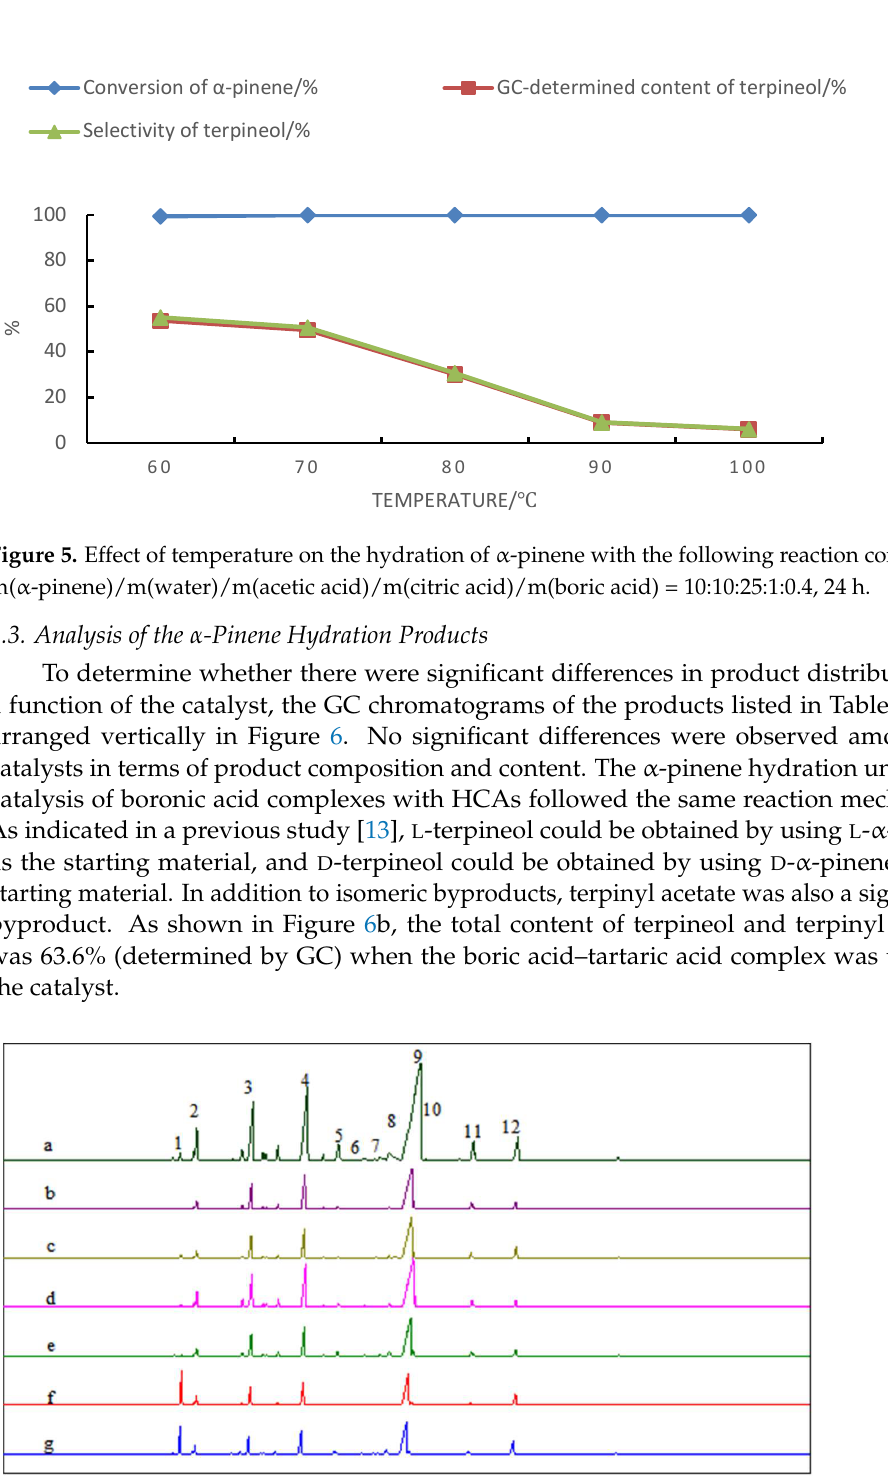
Figure 6. GC chromatograms of the α - pinene hydration products when boric acid–HCA complexes were used as the catalyst: ( a ) citric acid; ( b ) L (+)-tartaric acid; ( c ) DL -mandelic acid; ( d ) L -(−)-malic were used as the catalyst: (a) citric acid; (b) L (+)-tartaric acid; (c) DL -mandelic acid; (d) L -( − )-malic acid; ( e ) D -(−)-lactic acid; ( f ) D -gluconic acid; ( g ) glycolic acid. Note: 1. α - pinene; 2. camphene; 3. acid; (e) D -( − )-lactic acid; (f) D -gluconic acid; (g) glycolic acid. Note: 1. α -pinene; 2. camphene; limonene; 4. iso-terα-pinene; 5. fenchyl alcohol; 6. β-terpineol; 7. (iso)borneol; 8. 4-terpineol; 9. α- 3. limonene; 4. iso-terpinene; 5. fenchyl alcohol; 6. β -terpineol; 7. (iso)borneol; 8. 4-terpineol; terpineol; 10. γ-terpineol; 11. bornyl acetate; 12. terpinyl acetate.